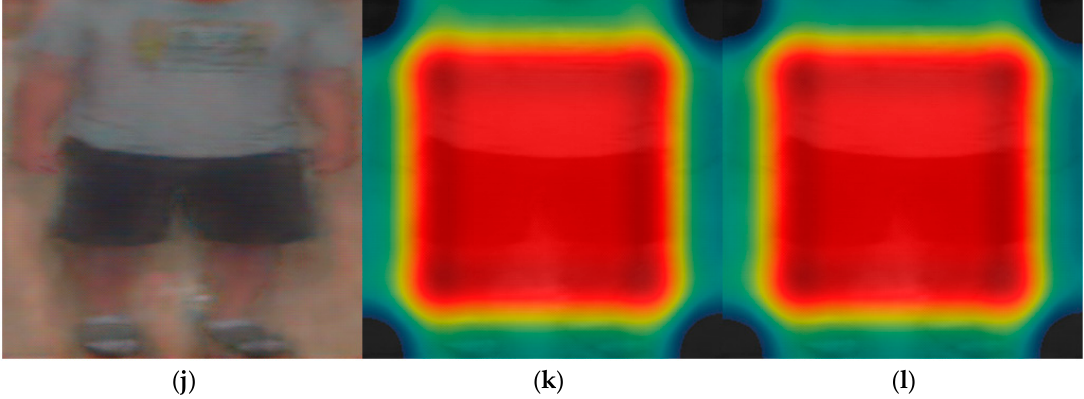
Figure 13. Results on class activation feature map on DFB-DB2. ( a , d ) Input face images, ( b , c , e , f ) results via VGG face net-16 in rectified linear units (ReLU) layer, ( b , e ) images from 7th ReLU layer, ( c , f ) images from 13th ReLU layer, ( g , j ) input body images, ( h , i , k , l ) results via ResNet-50 in batch normalized layer, ( h , i ) images from last batch normalized layer on conv5 2nd block, ( k , l ) images from last batch normalized layer on conv5 3rd block.